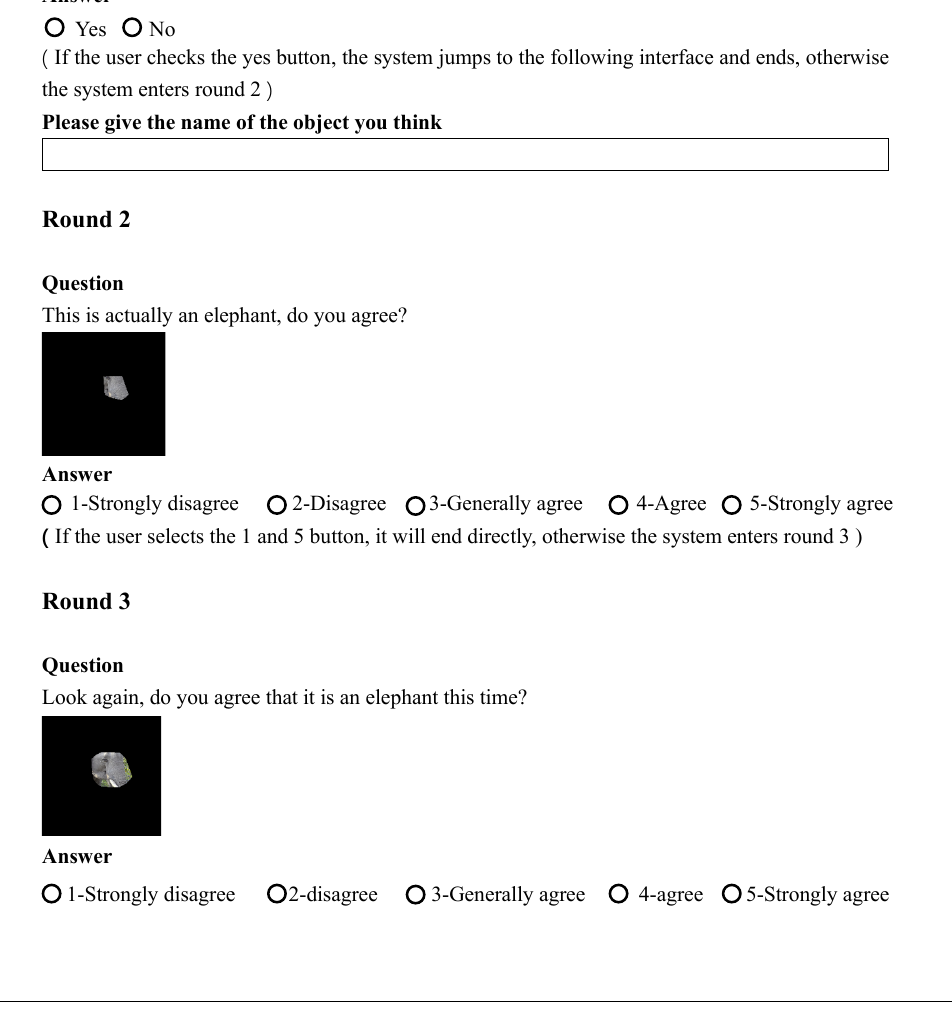
Figure A1. User satisfaction evaluation